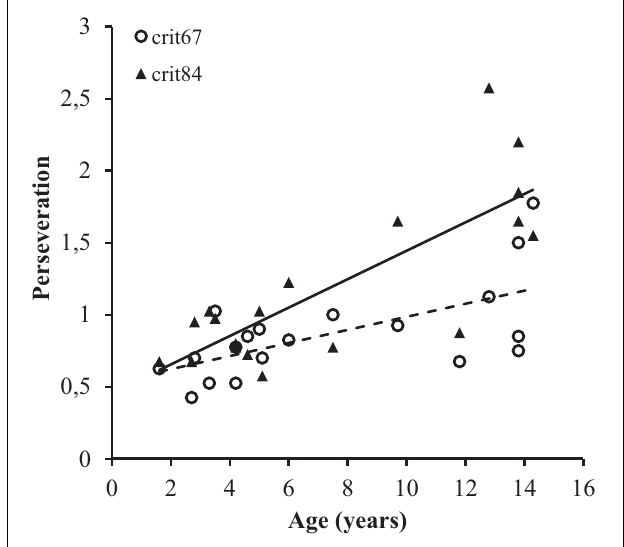
FIGURE 3 | Mean number of perseveration responses obtained during the post-reversal trials, as a function of the Age of participants and Learning Criterion. The dotted line corresponds to the criterion 67%.